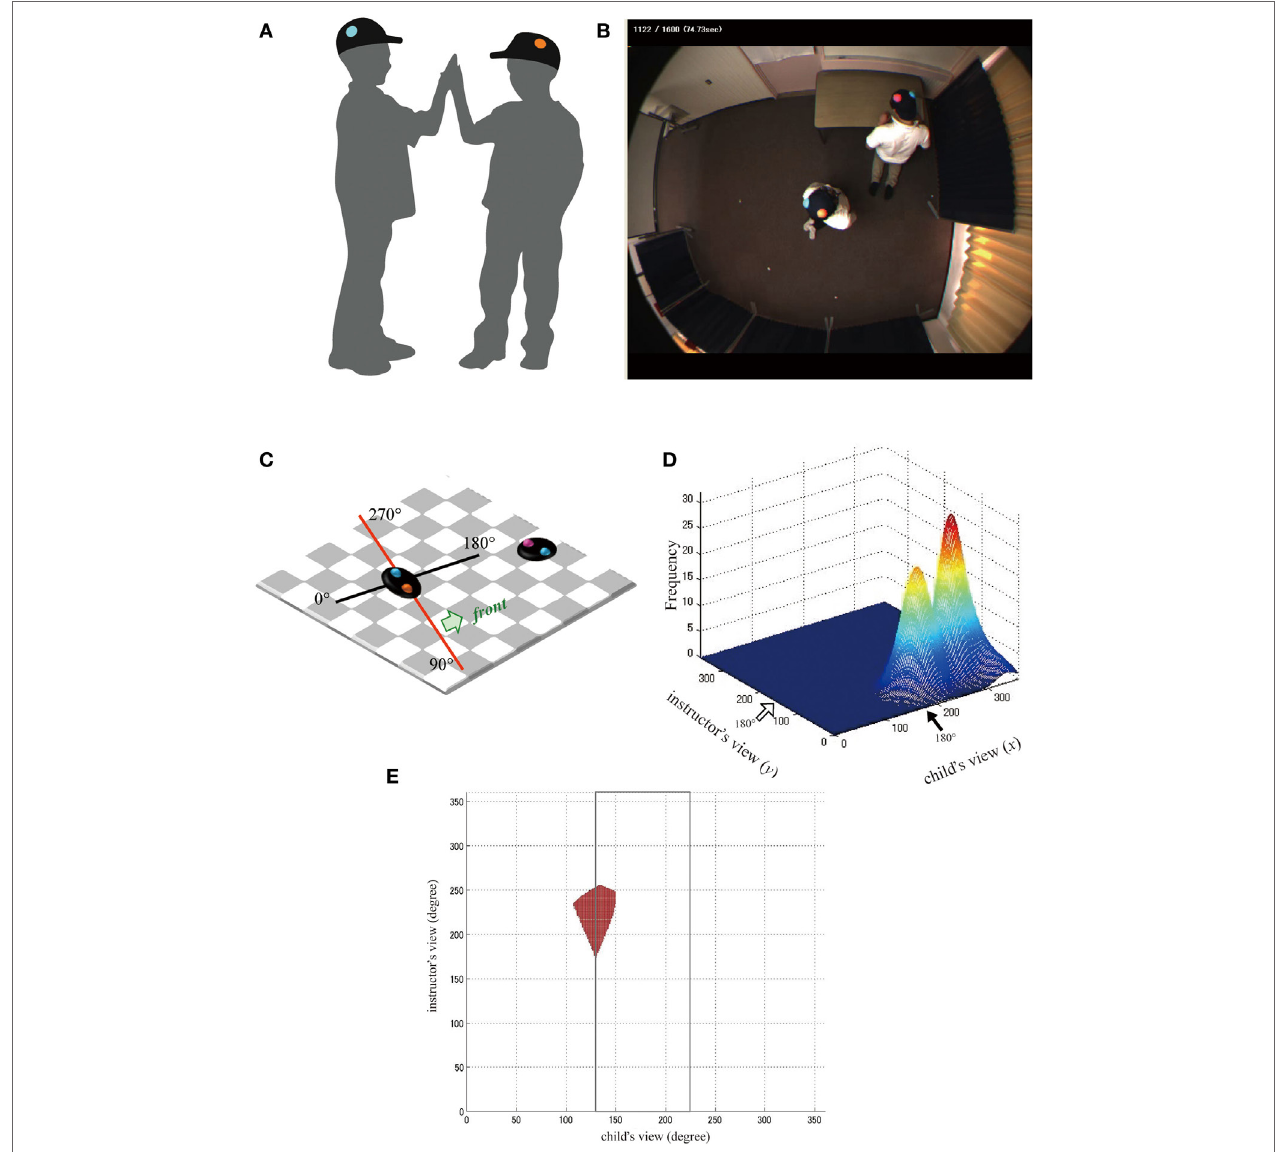
FiguRE 2 | Illustrations of the two-dimensional motion capture system and results of pre-helping behavior. (a) Children and instructors wore a hat with markers in different colors. (B) Video frame of session recorded by digital video cameras installed on the celling. (C) Positional information of a child and his instructor on a two-dimensional surface; an angle of 180° indicates that the child was in front of the instructor. (D) Example of Gaussian distribution representing the spatial profile of a child’s attention before helping behavior. The black arrow indicates the range of x -axis (in degrees) where the instructor was in front of the child, and the white arrow indicates the range of y -axis (in degrees) where the child was in front of the instructor. (E) Difference in pre-helping behavior between ASD (pre-baseline period) and typically developing children. In the region colored in red, children with ASD showed a significantly greater value of frequency compared to typically developing children ( α = 0.067). The area indicated by the gray rectangle indicates the range of x -axis (in degrees) where the instructor was in front of the child. The children with ASD looked straight at their instructor more often than did the typically developing